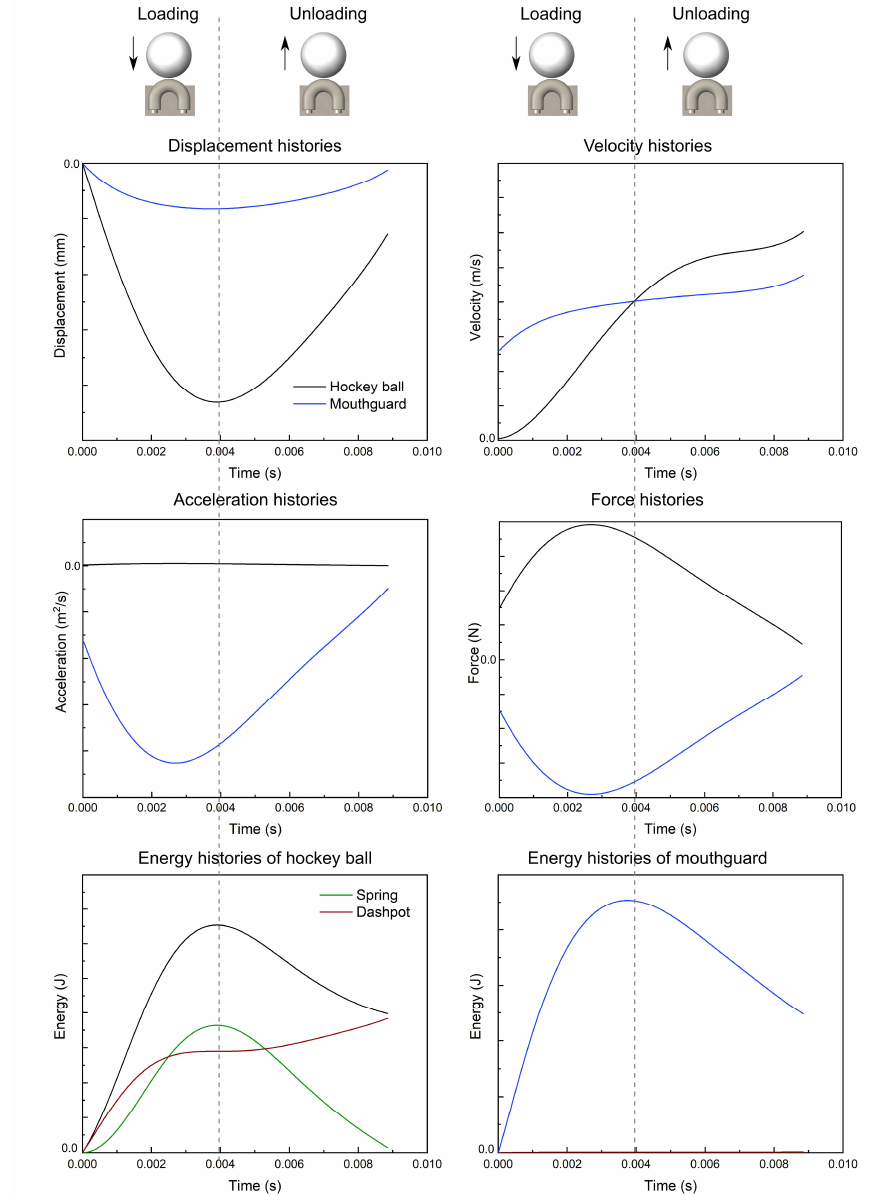
Figure 4. Representative illustration of the solutions for the 2DOF mass-spring-damper model system during loading and unloading of the mouthguard. The analysis starts when the hockey ball and mouthguard first come into contact and ends when they lose contact, in the following sequence: (1) The displacement histories measured using the high-speed images are used to calculate the corresponding velocity histories for the hockey ball and mouthguard separately. (2) The equation of motion obtained from the 2DOF system is used to calculate the individual accelerations for hockey ball and mouthguard. (3) Then the force is calculated considering the acceleration and mass of the ball and mouthguard individually. (4) The energy histories are then calculated from the force histories and the displacement histories for the mouthguard and